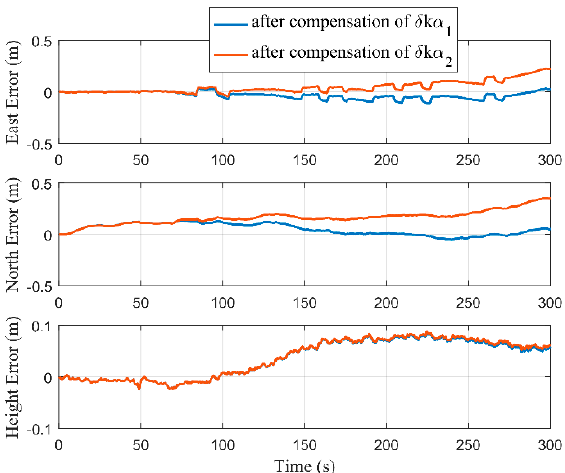
δ k α and δ k α . δ k α and δ k α . Figure 13. Positioning errors of DR calculations after compensation of δ k α 1 2 1 and δ k α 2 1 2